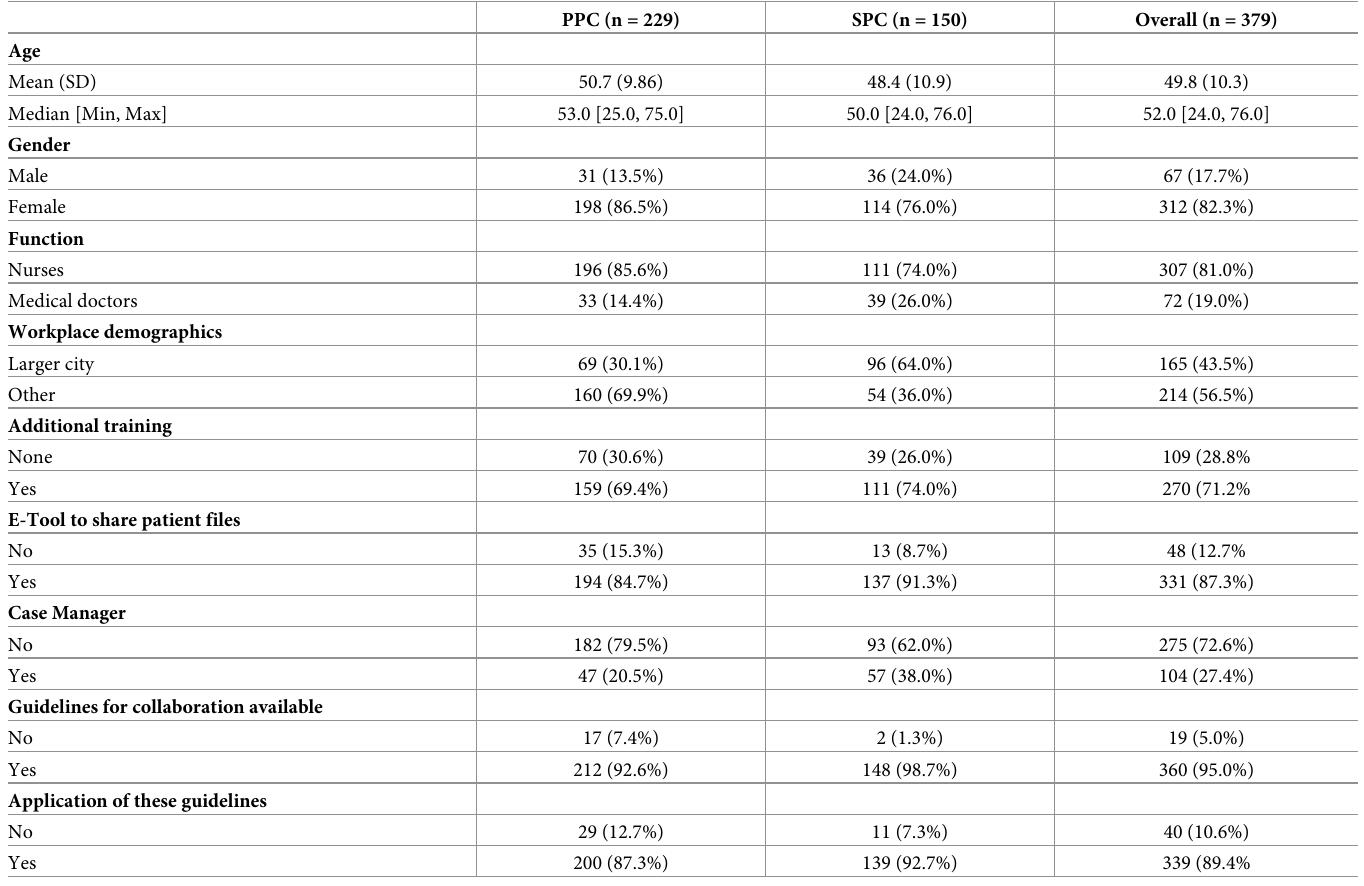
Table 1. Baseline demographic of the study sample of n = 379 palliative